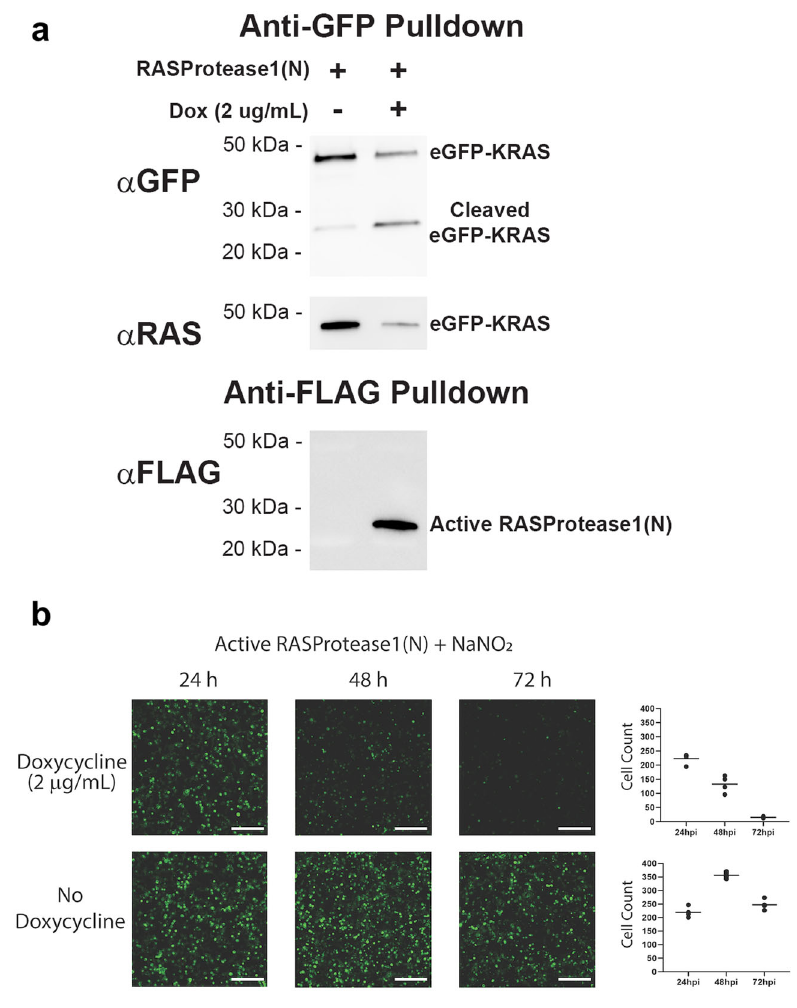
Fig. 8 RAS-speci fi c protease activity in cells. a Western blot analysis of cells co-transfected with eGFP-KRAS and RASProtease shows the appearance of a KRAS cleavage product upon induction of the active protease when probed with an anti-GFP antibody following a GFP pull-down. Sodium nitrite was added to the cell culture medium at a fi nal concentration of 1 mM to mitigate potential variability in cellular nitrite concentrations. Appearance of this product coincides with depletion of a RAS-reactive band when probed with an anti-RAS antibody. Appearance of cleaved eGFP-KRAS also coincides with expression of activated protease that has cleaved its inhibitory I-domain. b Induction of the active protease in HEK 293 T cells at 24 h after transfection with nitrite supplemented culture medium results in a marked decrease in GFP fl uorescence at 48 and 72 h after transfection compared to the same cells without induction of protease expression. The scale bar is 200 µ